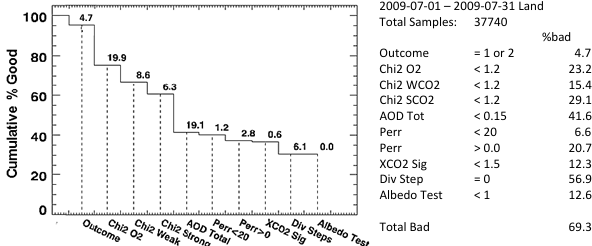
Fig. 10. Throughput of post-screening filters for July 2009. His- togram of reductions in the number of soundings by each step in the screening process (left) and the filter criterion and total frac- tion of the soundings that would be eliminated by each filter (right). The filters are applied from left to right, such that bad soundings are rejected by the first filter criterion that they fail. Chi2 O2, Chi2 Weak, and Chi2 Strong are the values of χ 2 for the ABO2, SCO2 and SCO2 bands, respectively. AOD Total is the column integrated cloud and aerosol opitcal depth at 755nm, Perr is the difference be- tween the retrieved surface pressure and the ECMWF prior, X CO Sig is the a postiori CO 2 error, Div Steps is the number of diverging steps, and Albedo Test refers to the “blended albedo“ filter intro- duced by Wunch et al. (2011), which rejects soundings over ice- covered surfaces where the albedo (and SNR) in the SCO2 channel is much lower than that for the ABO2